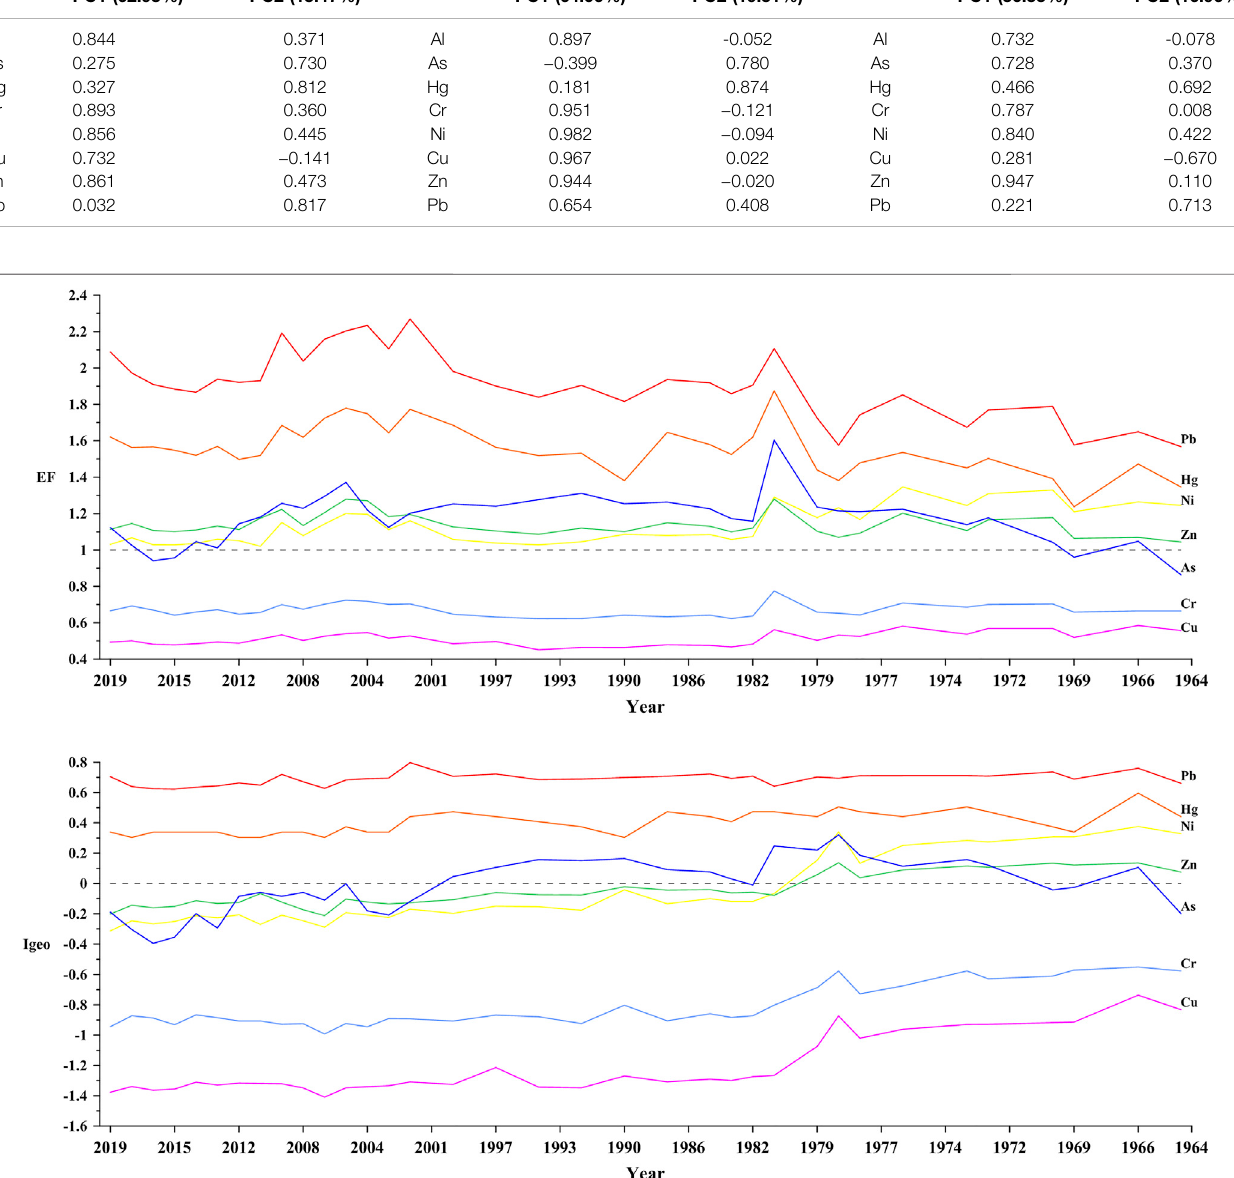
Frontiers in Earth Science |